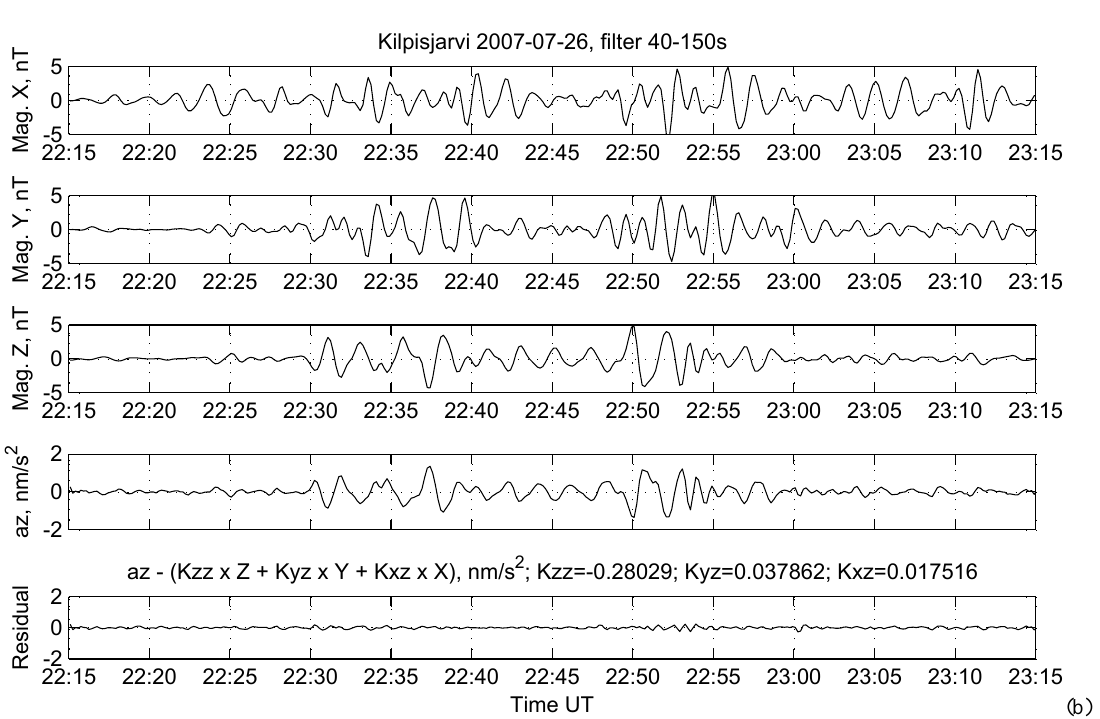
Fig. 11. (a) Case of Pc4 pulsations observed in Kilpisj ¨ arvi on 9 June 2007. Magnetic disturbances in all three components of the magnetic field (three top panels) are pass filtered in the 40–150s period band, and seismic output ( a z ) is filtered in the same way. Bottom panels show residual seismic signals after magnetic effects being subtracted, with the linear coefficients derived from the multi-factor regression analysis. Red lines indicate time interval of glacial seismic event from Greenland (according to Nettles and Ekstr¨om, 2010). (b) Same as (a) but for the case of Pi2 pulsations observed in Kilpisj¨arvi on 26 July